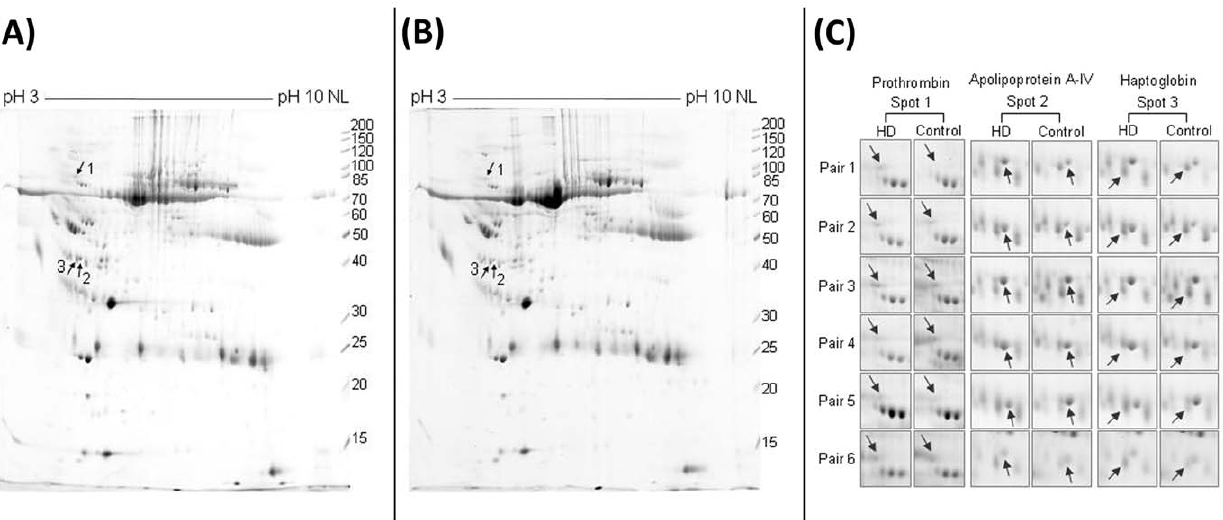
9 age-matched controls using western blot analysis or ELISA. The levels of prothrombin in CSF and serum from 9 HD patients (age, Fig. 2. Age did not has an effect on CSF prothrombin/Alb ( p =0.90), Apo A-IV/Alb ( p =0.30), and haptoglobin ( p =0.65) levels. The CSF prothrombin/Alb ratio (male, 0.30 [0.24 to 0.40]; female, 0.21 [0.17 to 0.27], p =0.05), Apo A-IV/Alb ratio (male, 0.12 [0.05 to 0.17]; female, 0.07 [0.06 to 0.10], p =0.16), and haptoglobin levels (male, 0.9 [0.24 to 2.67]; female, 0.42 [0.23 to 0.82], p =0.18) showed no significant difference between male and female group. The prothrombin/Alb ratio in CSF of HD patients (0.30 [0.21 to 0.40]) was increased compared with the controls (0.22 [0.16 to 0.26]) ( p =0.048). The ratio of prothrombin/Alb in serum of HD patients (0.30 [0.24 to 0.45]) was not different from those of controls (0.35 [0.30 to 0.43]). Albumin quotient (Qalb, CSF albumin/serum albumin), a marker of blood-brain barrier (BBB) function revealed no significant difference when comparing the HD patients (4.7 [4.1 to 6.6] *10 2 3 ) with the controls (4.0 [3.4 to 6.3]*10 2 3 ). The Apo A-IV/Alb ratios in CSF and serum from 9 HD patients (age, 43.4 6 3.4) and 9 age-matched controls (age, 45.7 6 4.7) are shown in Fig. 3. The ratio of Apo A-IV/Alb in CSF of HD patients (0.12 [0.08 to 0.15]) was significantly higher than that of controls (0.06 [0.03 to 0.09]) ( p =0.005), while ratio of Apo A-IV/Alb in serum of HD patients (0.23 [0.19 to 0.29]) was not different from those of controls (0.31 [0.23 to 0.39]). The Qalb were not different between HD patients (4.7 [4.1 to 6.6]*10 2 3 ) and controls (3.4 [2.6 to 6.6]*10 2 3 ). CSF Apo A-IV/Alb ratio was not correlated to BMI in HD patients. In order to know if the elevated CSF Apo A-IV is specific to HD, we compared CSF Apo A-IV/ Alb ratios between 5 controls (0.058 [0.013 to 0.154]) and 5 patients with Guillain–Barre´ syndrome (0.095 [0.055 to 0.126]) and there was no difference between them. The haptoglobin levels in CSF and serum from 9 HD patients (age, 43.4 6 3.4) and 9 age-matched controls (age, 41.1 6 4.1) are shown in Fig. 4. CSF haptoglobin concentration of HD patients (0.9 [0.48 to 2.50] m g/ml) was significantly higher than those of controls (0.38 [0.22 to 0.53] m g/ml) ( p =0.014), whereas haptoglobin concentration in serum of HD patients (876 [799 to